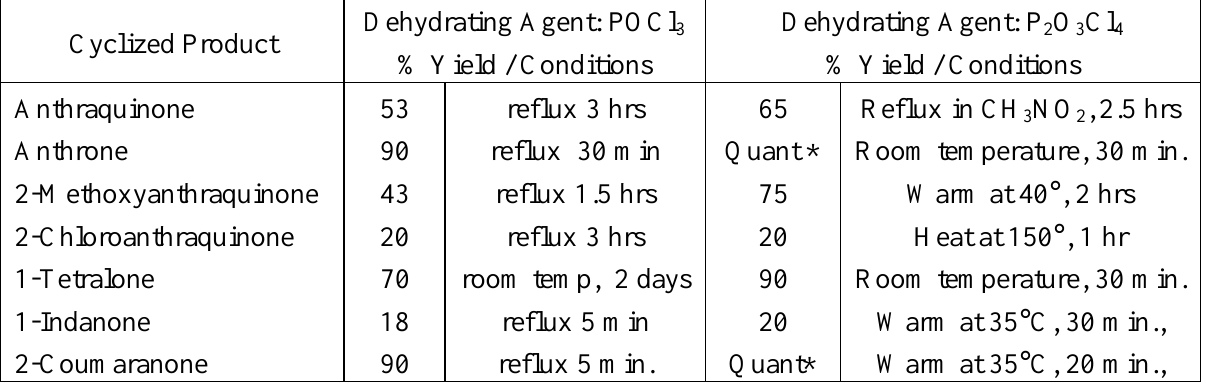
and P O Cl 3 2 3 4